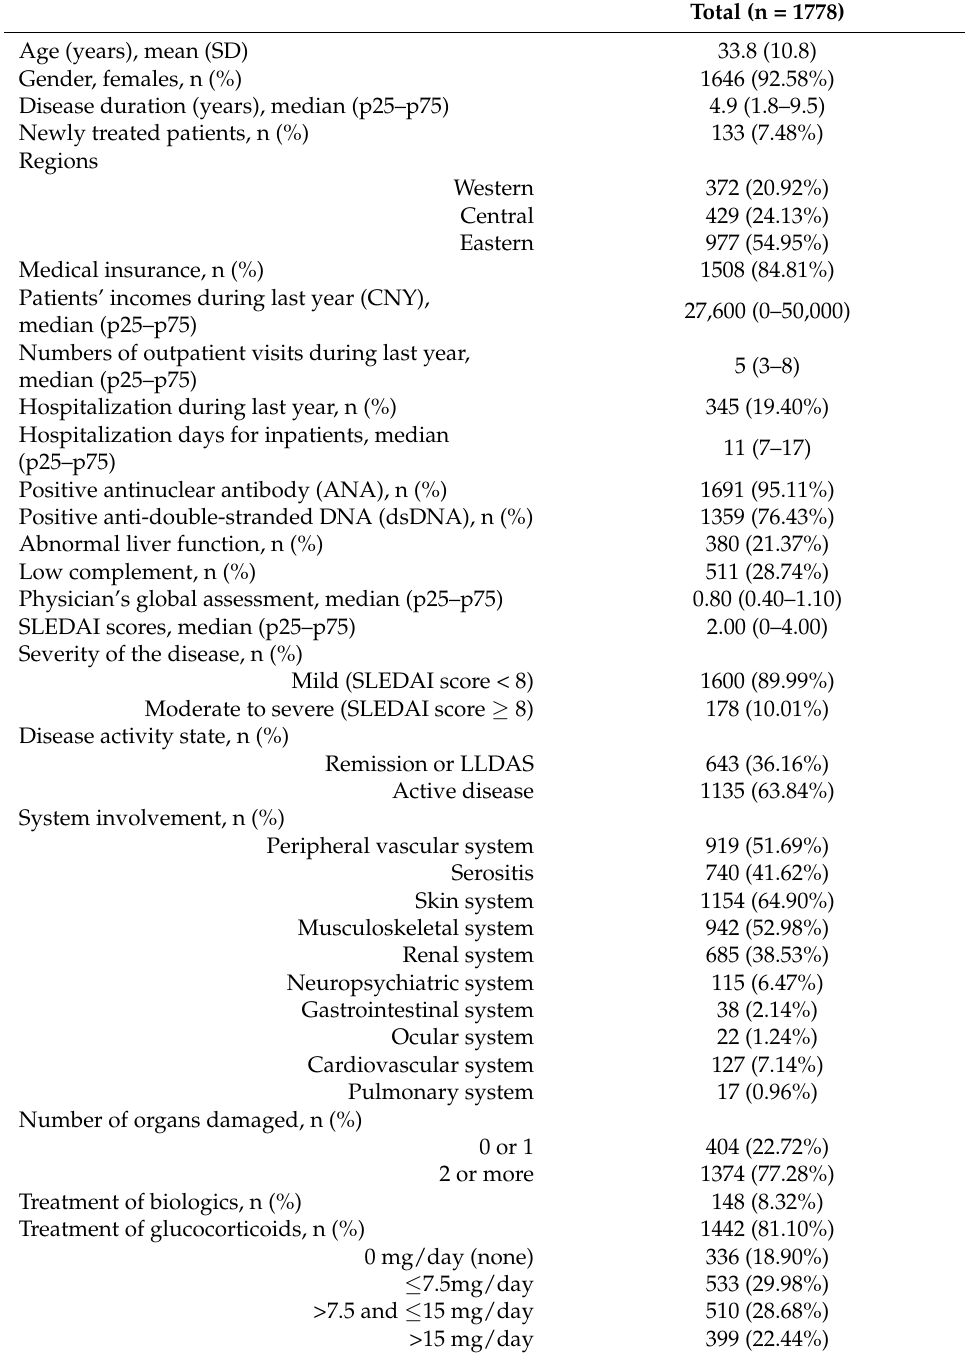
Table 1. SLE patient demographics and clinical